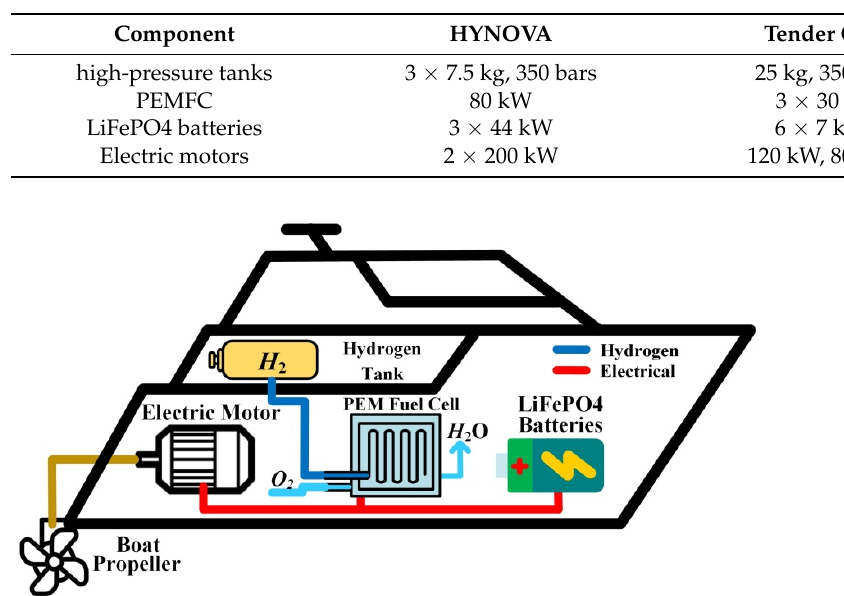
Figure 10. Propulsion principle of a hydrogen-powered yacht or vessel.